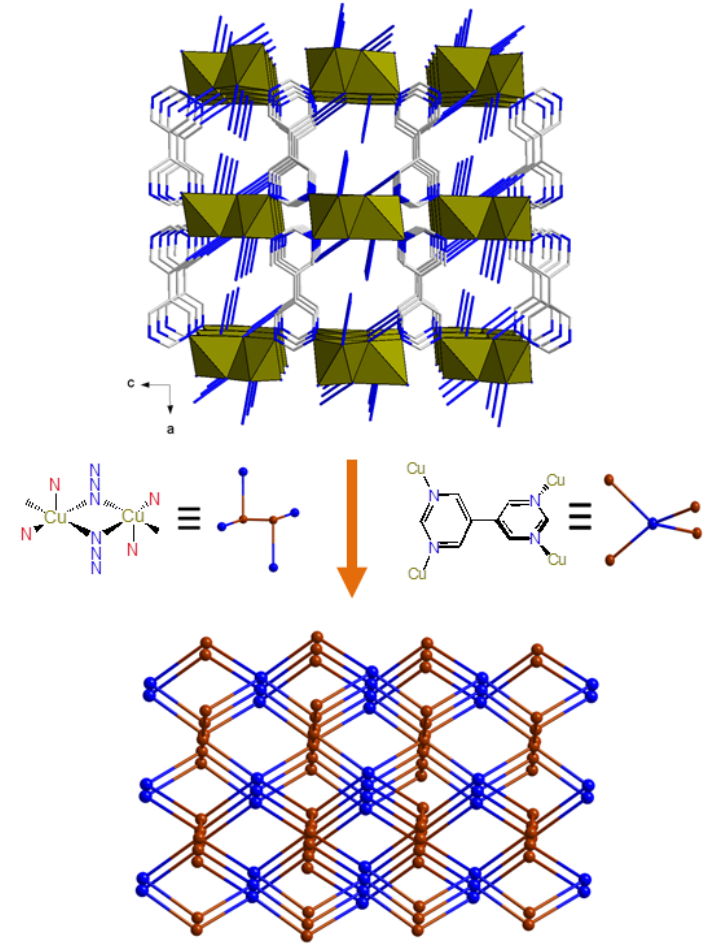
Figure 4. Schematic representation of the (3,4)-connected tfi topologic network Compound 2 ; the EO- and EE-azides are represented by green; the bpym and Cu center are represented by blue and brown spheres, respectively.